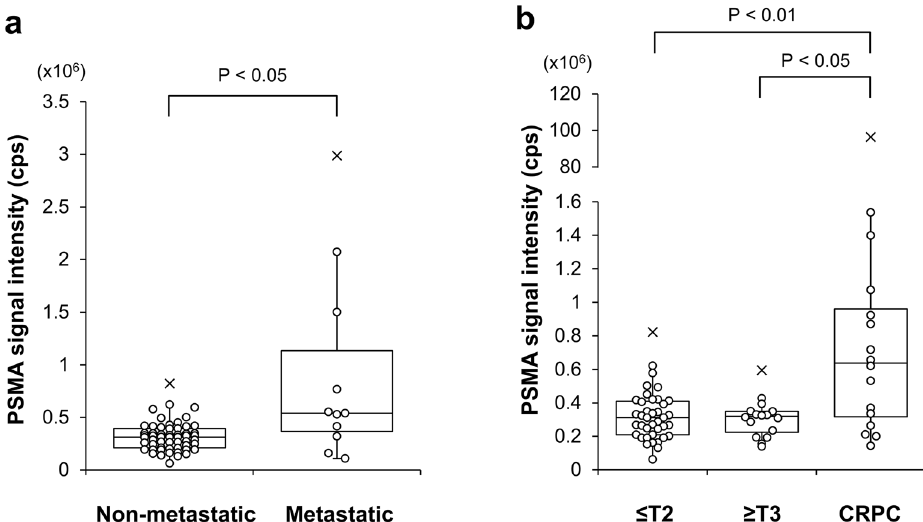
Figure 6. Measurement of the PSMA-EV levels in serum of PC patients. The PSMA-EV levels in serum was determined after purification of EVs from serum by Tim4. Patients with therapy-naïve PC and CRPC were analyzed. Comparisons were made between non-metastatic (n = 55) and metastatic patients (n = 11) ( a ) and among organ-confined PC patients (≤ T2, n = 39), locally-advanced PC patients without metastasis (≥ T3, n = 16) and CRPC patients (n = 16) ( b ). Data are shown in the ’box and whiskers’ graph with interquartile range (IQR: box), median (thick vertical line in the box) and 1.5 IQR (whiskers). x denotes outliers.